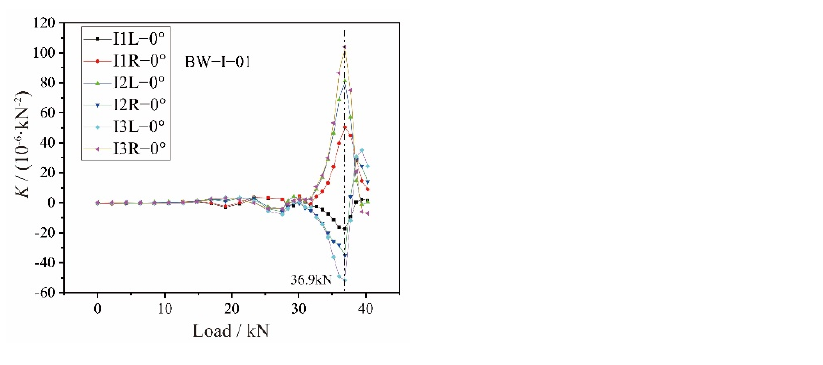
Figure 7. The experimental K -load curves of the different strain measurement points on the BW-I- 01 PWF composite